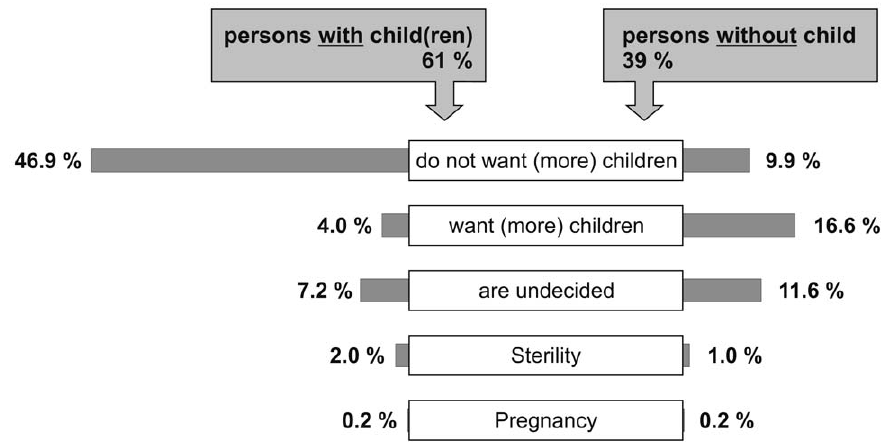
Figure 1. Decision in favour for against having one (more) child. doi:10.1371/journal.pone.0050113.g001 PLOS ONE |